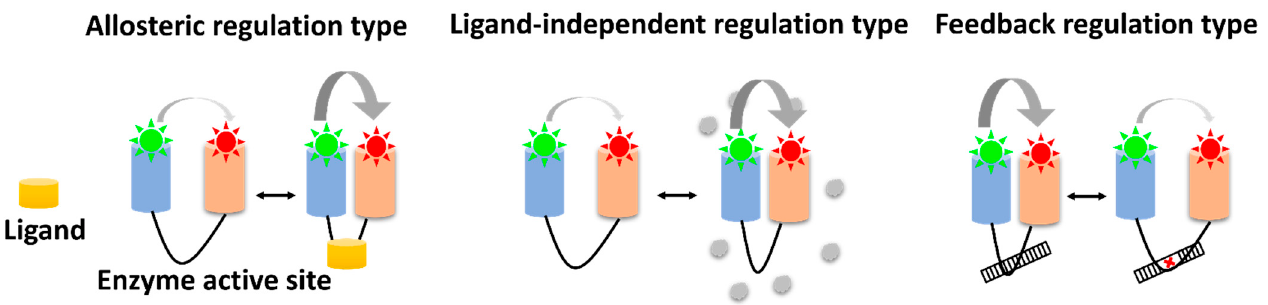
Figure 2. Different mechanisms of enzyme conformational dynamics. Three different categories are discussed in this review: allosteric regulation, ligand-independent regulation, and feedback regulation types. The green symbol represents the donor, and the red symbol denotes the acceptor. The conformational changes are monitored by collecting the changes in the intensities of the two fluorophores under a specific condition of interest.